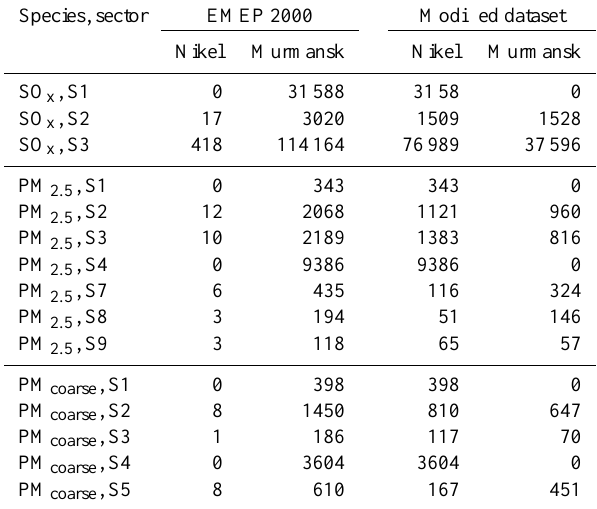
Table 4. EMEP data for 2000 (WebDab before 2006) and corrected emission data for the Nikel plant and Murmansk (unit: Tonsyr − 1 ). Modified dataset is suggested as reference values for 1990s–mid-